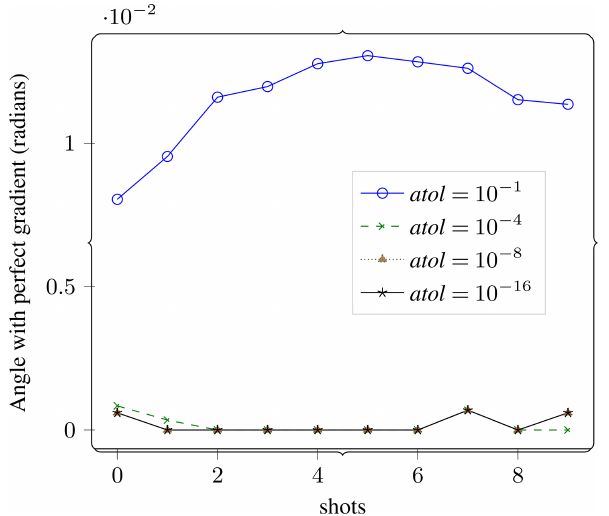
Figure 13. Shot stacking. The gradient is first computed for each individual shot and then added up for all the shots. In this experi- ment we measure the propagation of errors through this step. This plot shows that while errors do have the potential to accumulate through the step, as can be seen from the curve for atol = 10 − 1 for compression settings that are useful otherwise, the errors do not accumulate significantly.